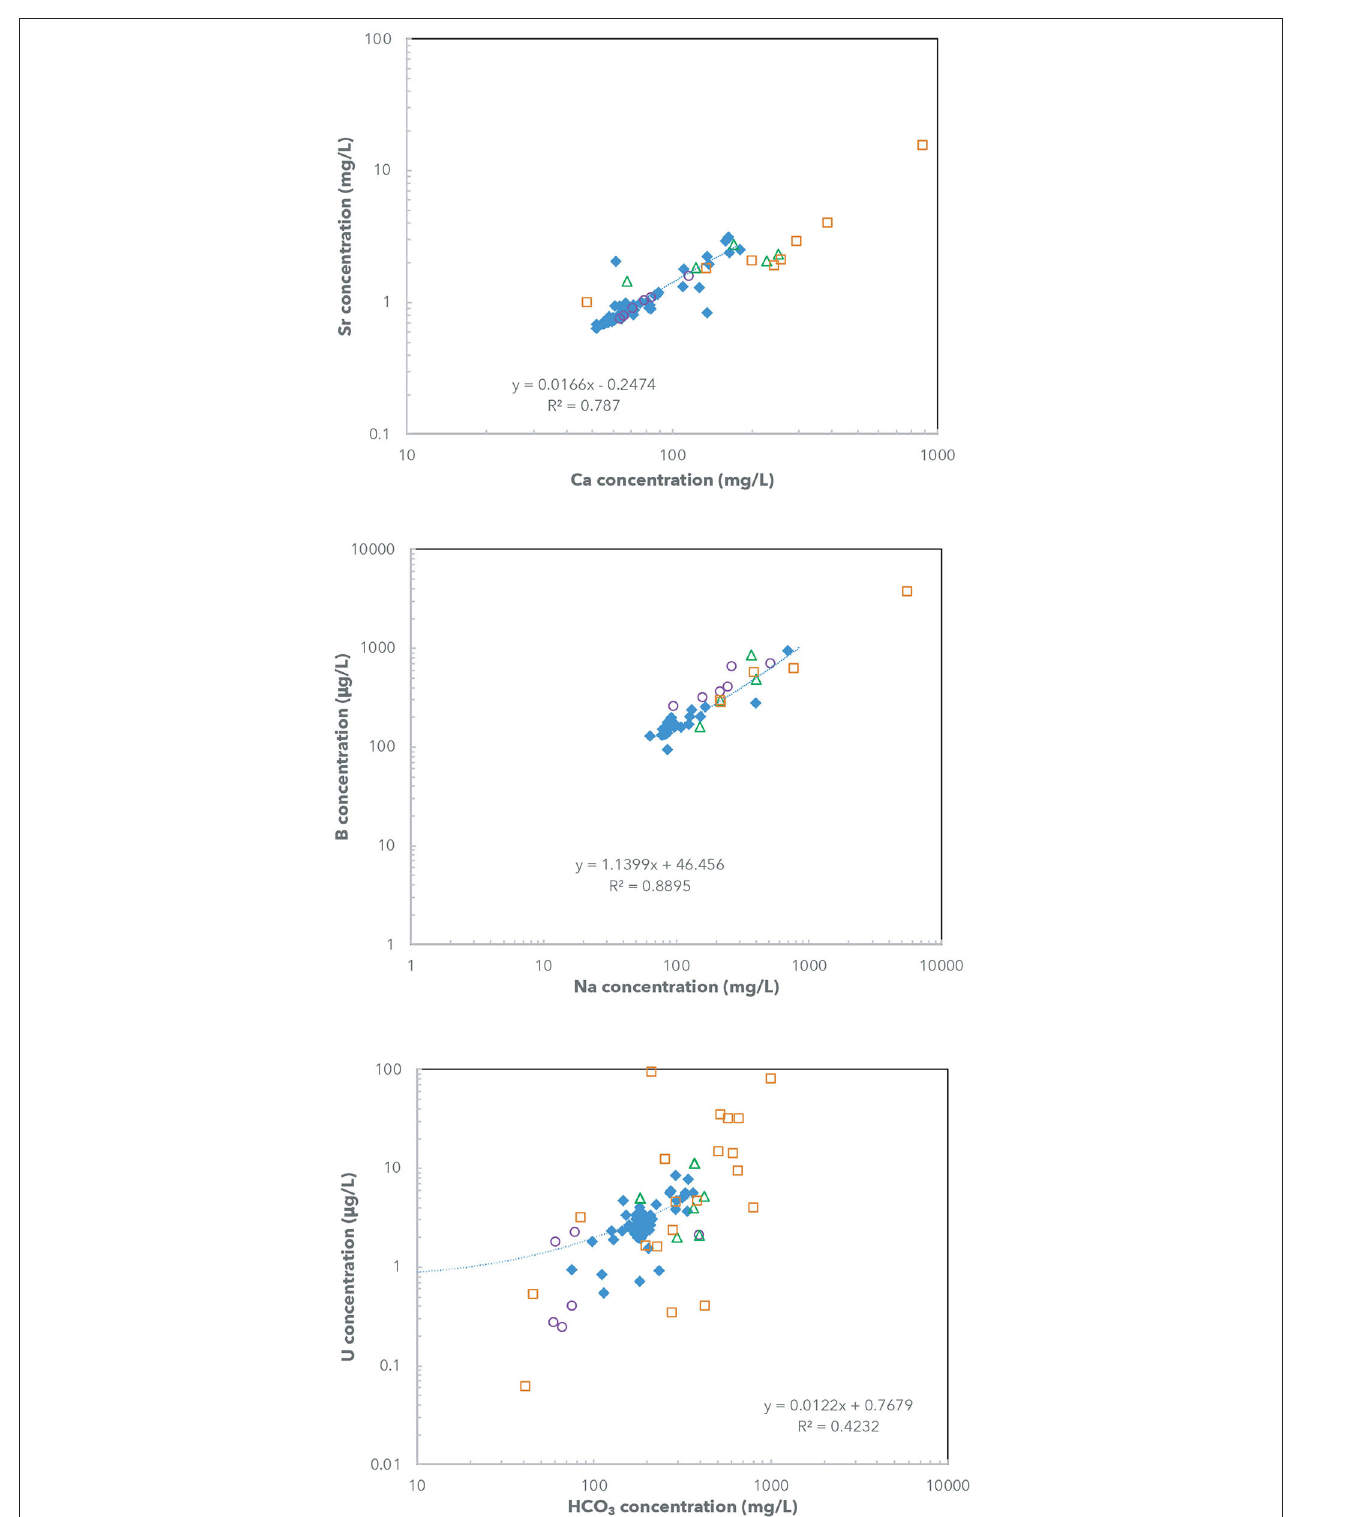
FIGURE 4 | (A) Sr vs. Ca concentrations (mg/L), (B) B vs. Na concentrations ( µ g/L), and (C) U vs. HCO 3 concentrations ( µ g/L), in Rio Grande river water, groundwater, agricultural canals and drains, and urban water (wastewater treatment plants: WWTP). Positive correlations for the Rio Grande river samples are indicated by linear fit